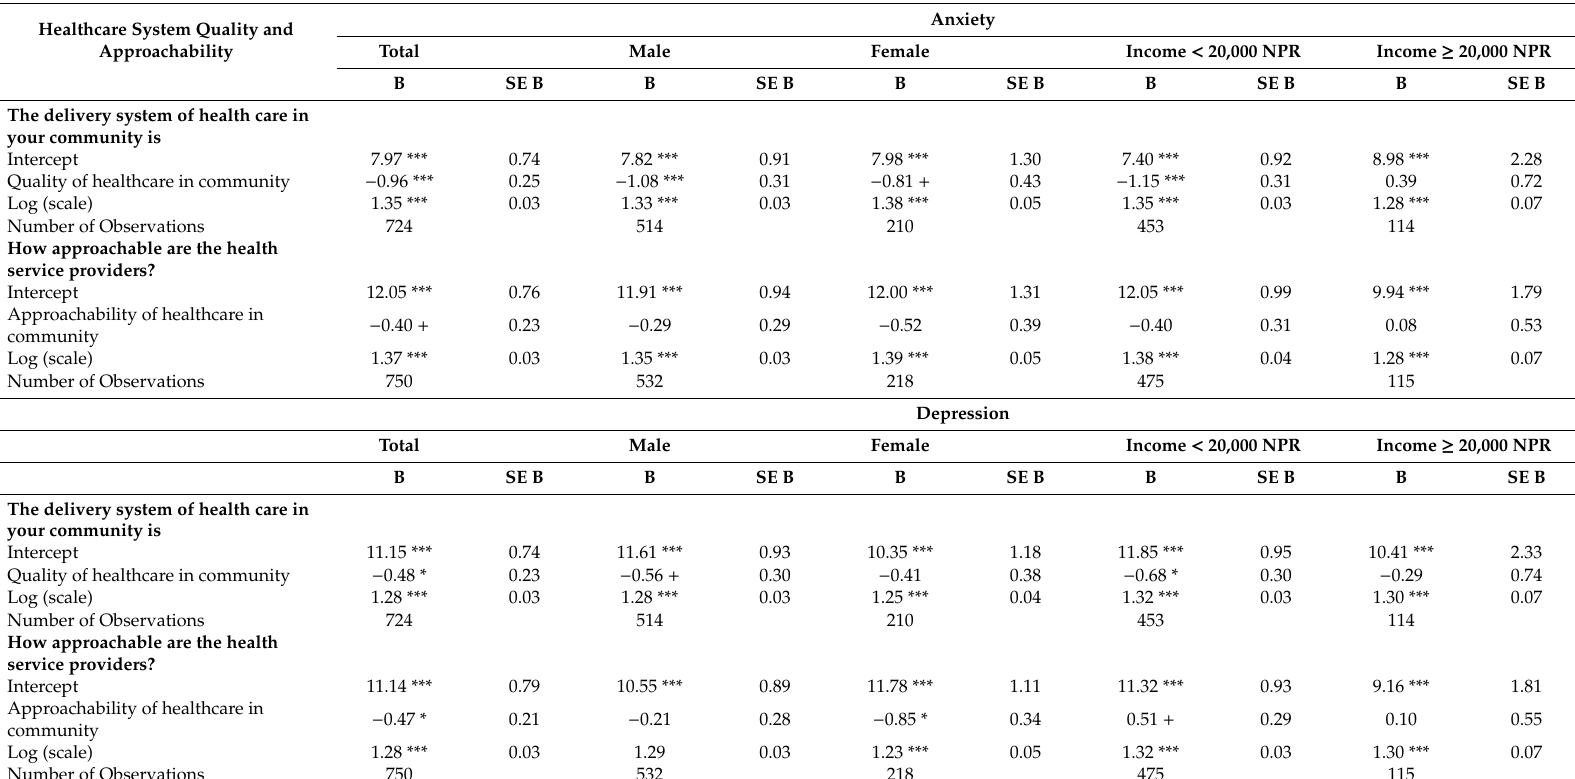
Table 6. Tobit regression results of approachability healthcare providers and healthcare delivery by depression and